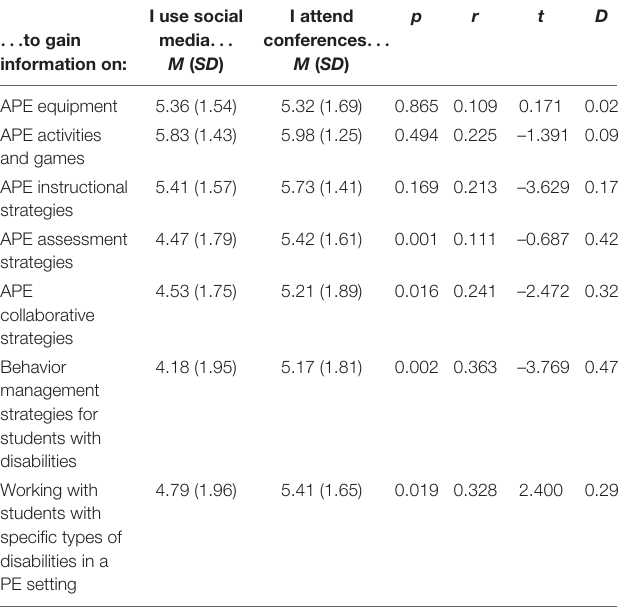
TABLE 3 | Differences in perceptions of social media and conference attendance for professional learning.